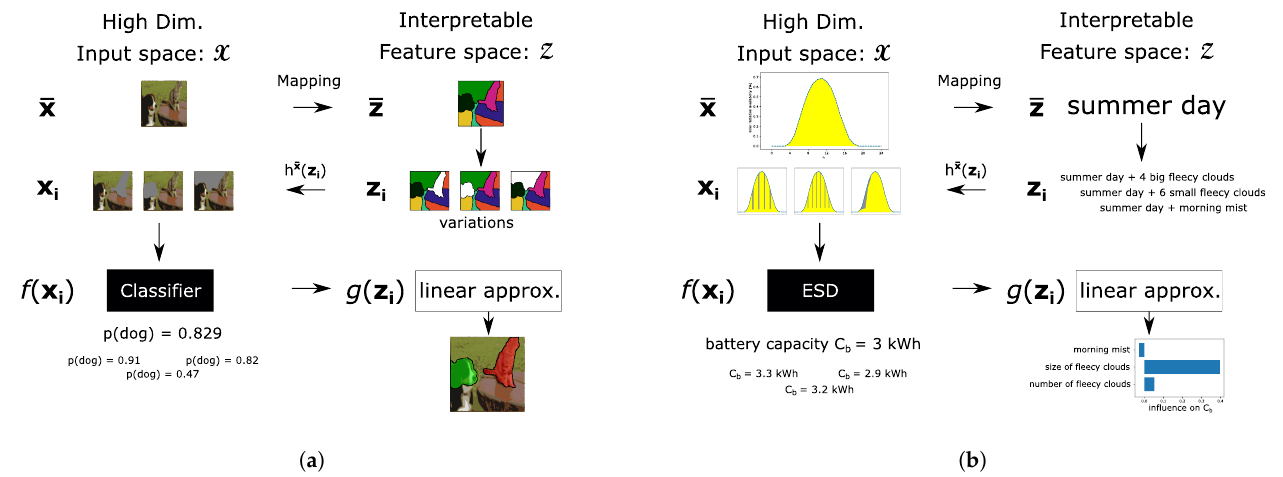
Figure 2. ( a ): The LIME method: For an image classifier where individual pixels of an input image ¯x have no explanatory power, an abstraction layer with interpretable features Z (here super-pixels) is created. Variations z i around the interpretable representation of the input image ¯z are made and mapped back to the input space X via h ¯x , i.e., by replacing each pixel belonging to a super-pixel with a single neutral color. The classifier f is applied to the modified inputs. LIME fits a linear model g ( z ) to the classifier’s outputs and uses g to explain the behavior of g locally around ¯x . ( b ): Proposed Method: For a high-dimensional input ¯x , e.g., a radiation time series, interpretable features ¯z i that could be relevant for explanation are identified. Variations z i around ¯z are made and mapped back to the input space X by h ¯x . The ESD model f is optimized for each input variation x i . A linear model g ( z i ) is fitted to the output of the ESD optimization, e.g., the cost-optimal battery capacity C b . The weights of the linear model g represent the relevance of the interpretable features for the output of the ESD model f locally around ¯x